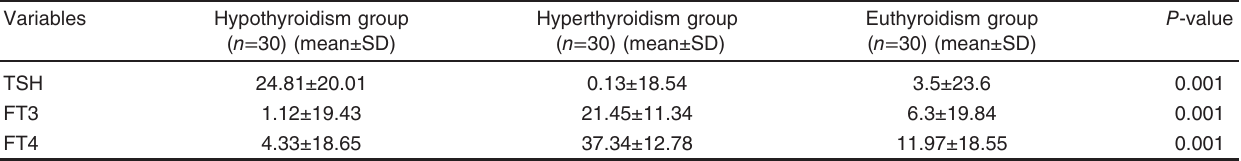
Table 2 Thyroid function test values of the studied groups Variables